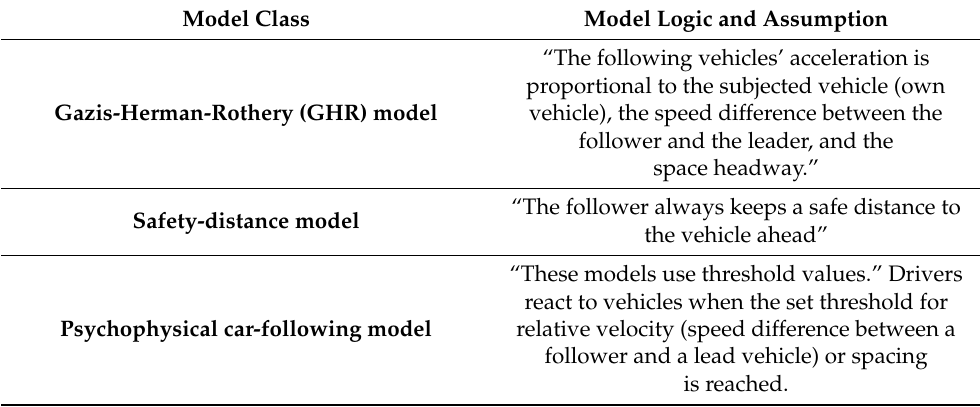
Table 1. Car-following models based on utilized logic